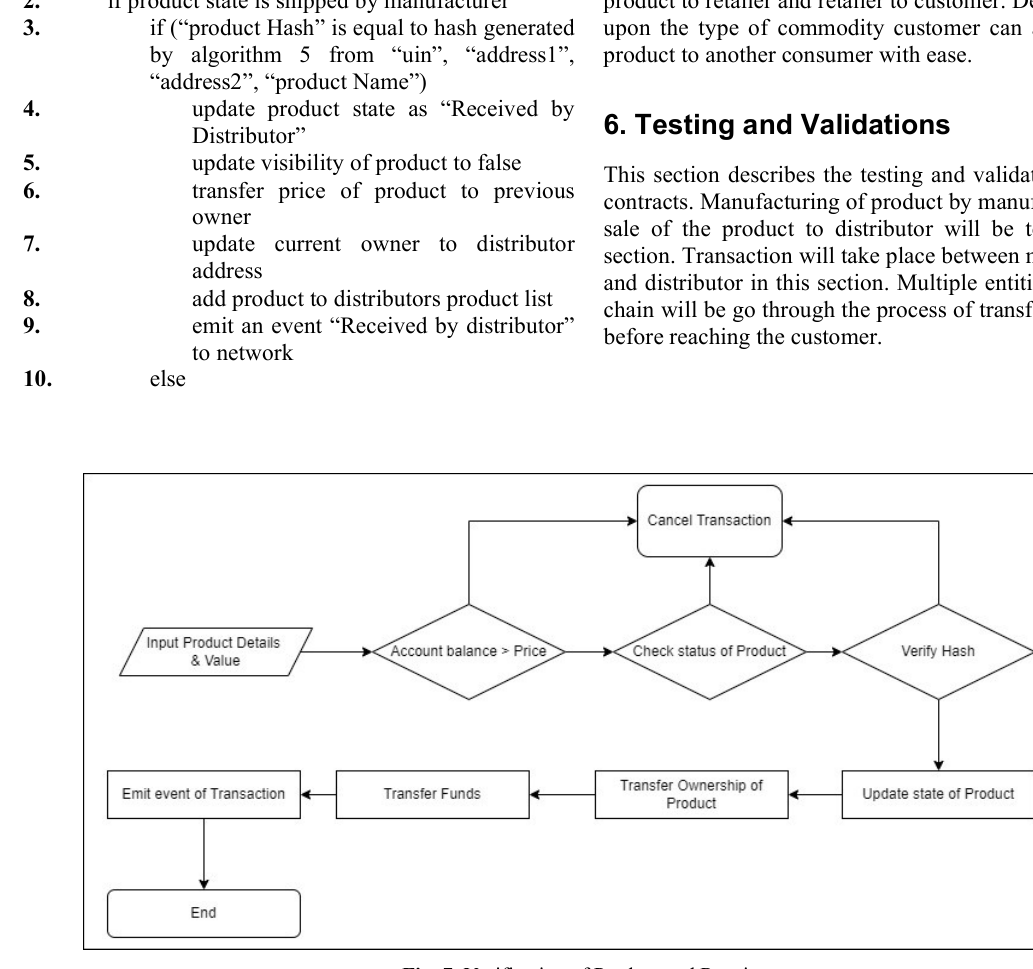
Algorithm 5: Generate Product Hash using Keccak 256